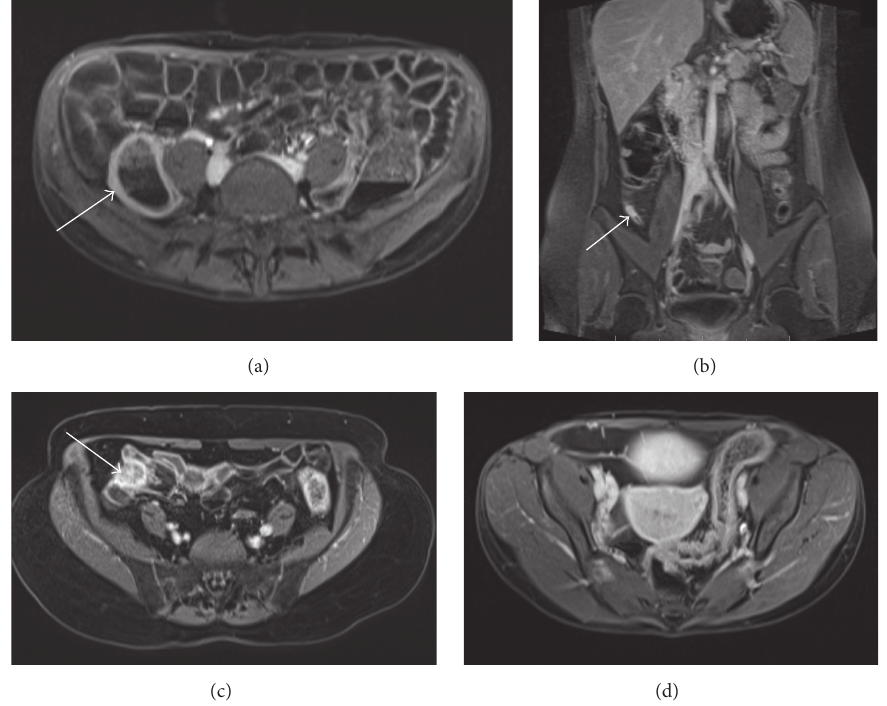
Figure 2: Colonic incidental findings: (a) enhancement of caecum (arrow) indicating colitis (axial T1 postgadolinium); (b) thickened, enhancing appendix (arrow, coronal T1 postgadolinium); (c) caecal cancer (arrow, axial T1 postgadolinium); (d) sigmoid colitis (axial T1